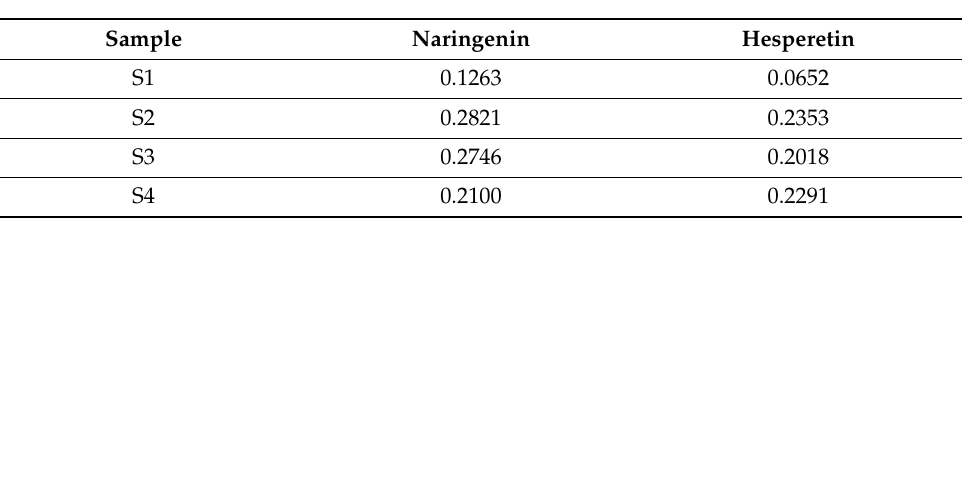
Table 5. Determination of naringenin and hesperetin in Jianqu samples with different fermentation times